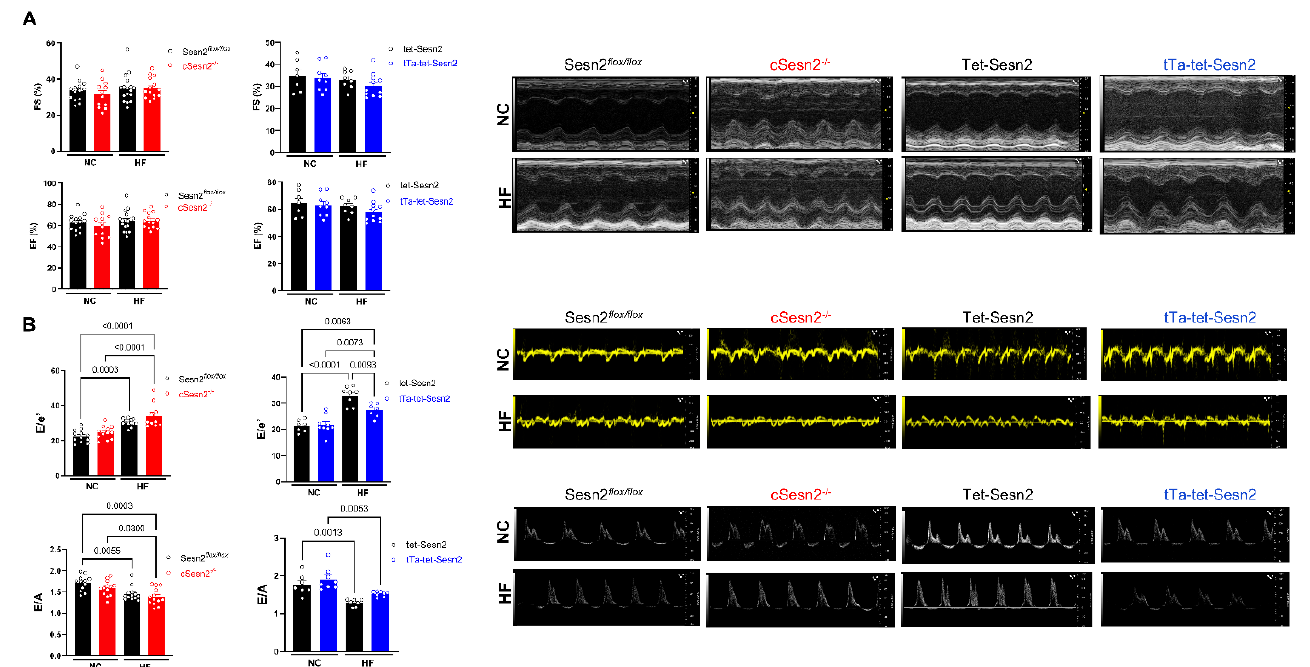
Figure 4. Effect of Sesn2 on cardiac function after 16 weeks of dietary intervention. ( A ) Systolic function of the heart (LVFS and LVEF). ( B ) Diastolic function of the heart (E/A and E/e (cid:48) ). n = 6–8 per group. Means ±